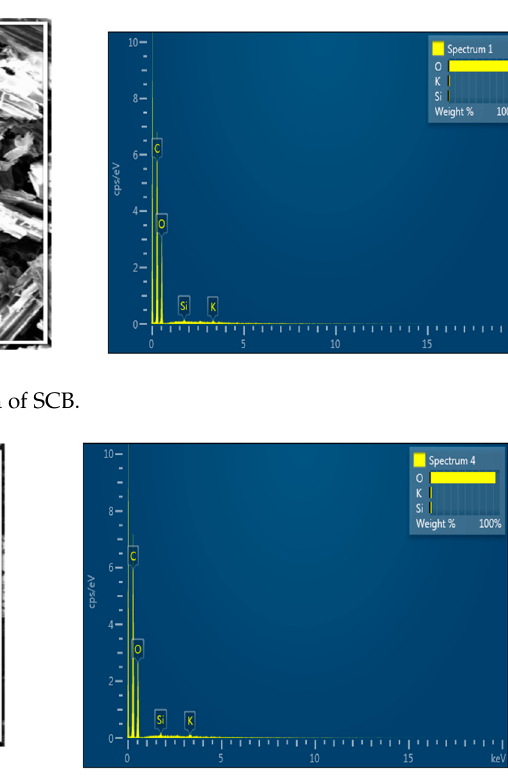
Figure 5. SEM images and EDS spectrum of OPS.